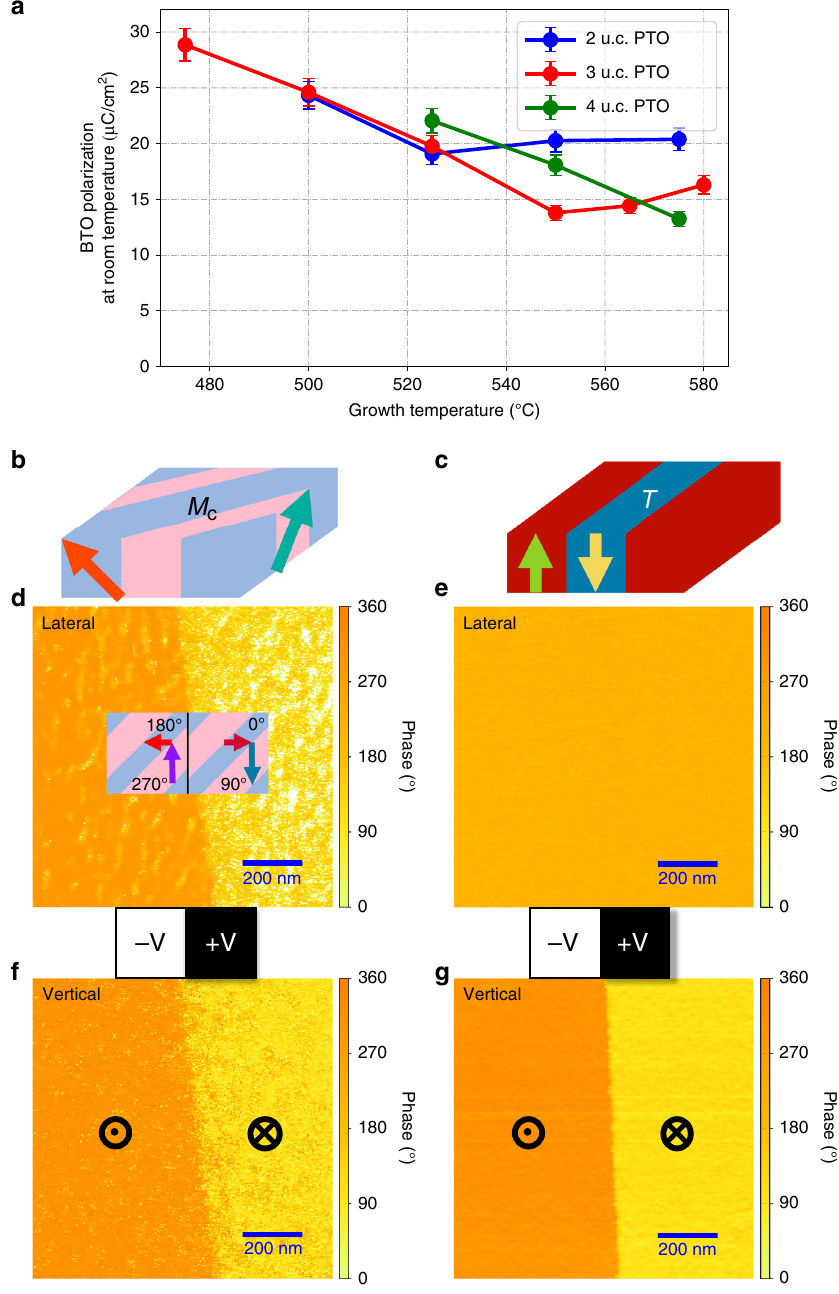
Fig. 3 Lateral and vertical PFM on fi lms grown on ferroelectric/paraelectric PTO and schematic views of the ferroelectric domain structures. Post-deposition polarization properties of fi lms: a Polarization of BTO fi lms grown on ultrathin PTO fi lms measured at room temperature (blue: 2 u.c. layers PTO, red: 3 u.c. layers PTO, green: 4 u.c. layers PTO). b – g Ferroelectric domains measured by vector PFM and their possible arrangements: schematics of Monoclinic M c ( b ) and Tetragonal ( c ) domain structures of BTO fi lms grown on paraelectric/ferroelectric three u.c. layers PTO fi lms, respectively. Two stable states of uniform and opposite polarization, up and down, were achieved by applying negative voltage in the out-of-plane direction on the left half side and positive voltage in the out-of-plane direction on the right half side of each fi lm. The larger micron scale domain structure is that written with the AFM tip. The smaller scale texture in the images is from the naturally occurring domains which are on the 20 – 60 nm length scale. In contrast with vertical response ( f , g ) there is no lateral phase PFM response ( e ) for the fi lm grown on ferroelectric PTO. On the other hand, the lateral cross section of domains (inserted image in d ) in the fi lm grown on paraelectric PTO indicates two polarization orientations with 90° domain walls in each state, and the lateral phase PFM image ( d ) does show the 180°/270° (up state) and 0°/90° (down state) domain con fi guration with four orientations. Source data are provided as a Source Data fi fi lm grown on ferroelectric PTO simultaneously increases with polarization of the fi lm as measured by hysteresis measurements PTO polarization and can be as large as doubled (29 μ C/cm 2 ) also depends on the magnitude of the PTO polarization during growth (Fig. 3a). Taking fi lms with three u.c. layers of PTO as an compared with the one of BTO fi lm grown on paraelectric PTO fi lm (14 μ C/cm 2 ). Vector PFM was then performed in order to example (red data, Fig. 3a), the out-of-plane polarization of a BTO